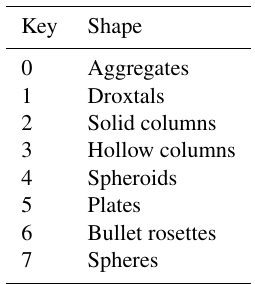
Table E1 refers to each key in the field ice_shape in the netCDF file and the corresponding ice crystal shape.